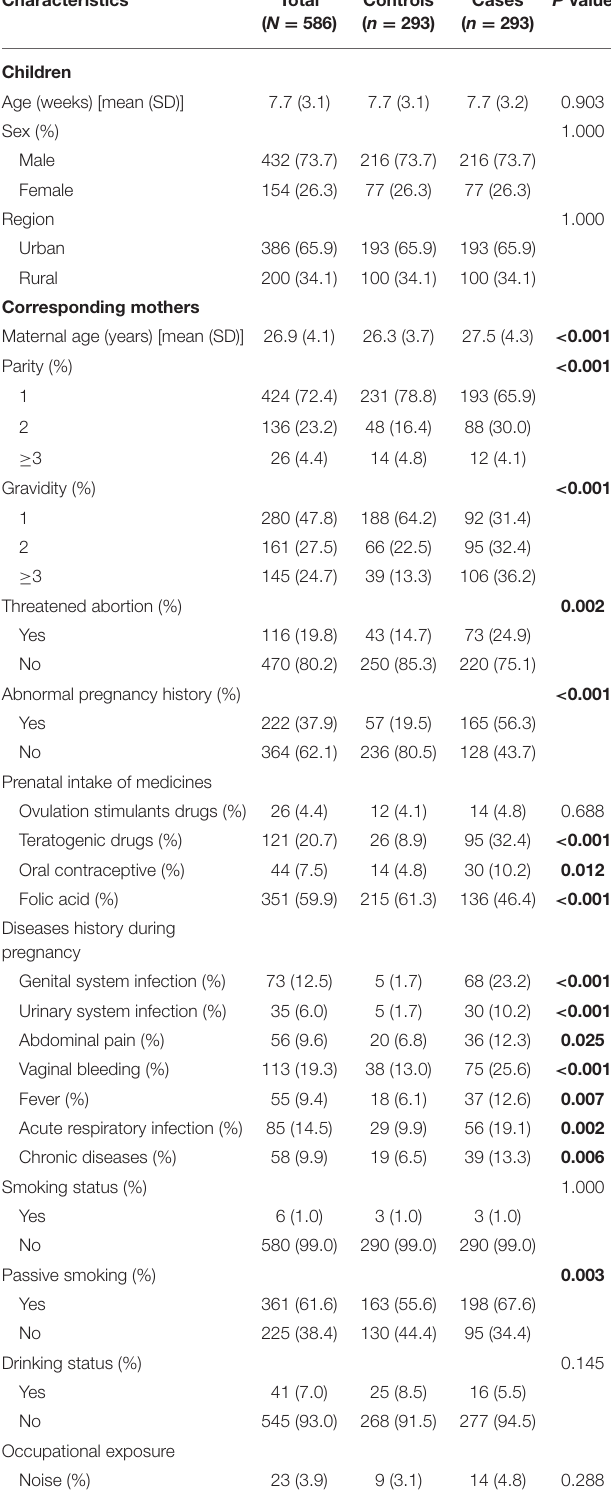
TABLE 1 | Basic characteristics of participants and corresponding